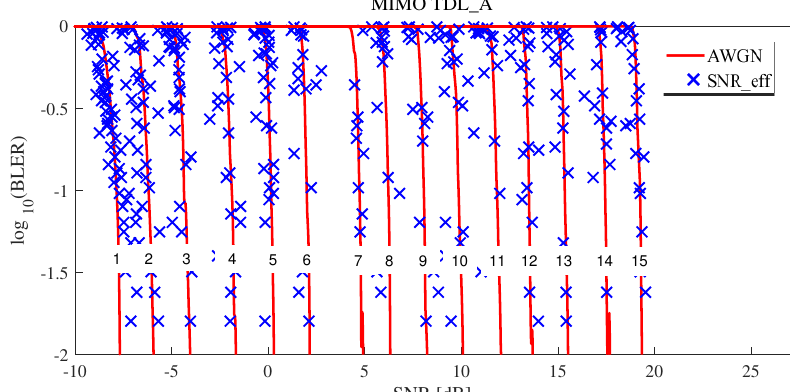
Figure 10. Effective SNR mapping results of the proposed ML-based EESM method under 5G TDL-A 2 × 2 MIMO for all